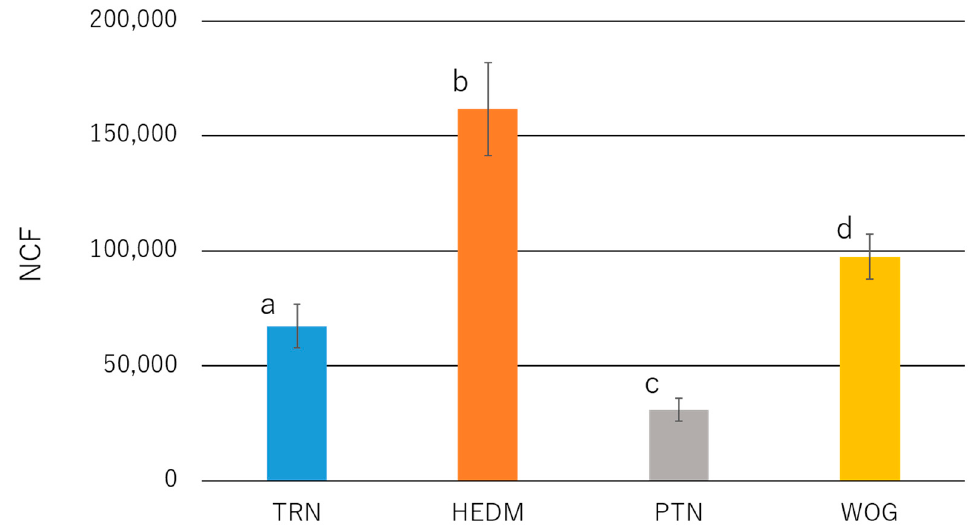
Figure 5. Number of cycles to failure (NCF) of NiTi rotary instruments subjected to a dynamic cyclic fatigue test. Values are means and standard deviations (n = 10). Groups with different letters are significantly different ( p < 0.05; one-way ANOVA and Tukey test).